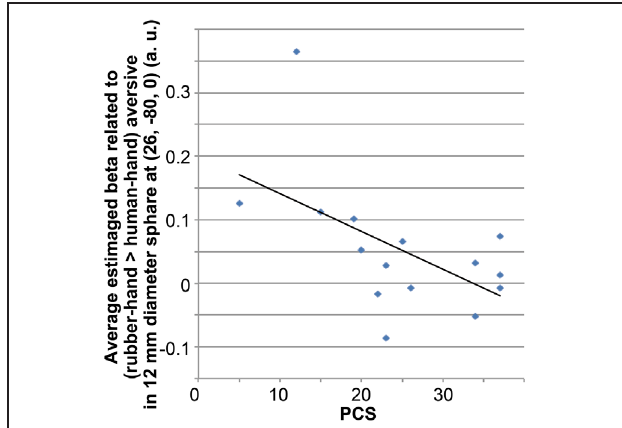
FIGURE 5 | Correlation between average beta value related to (rubber-hand > human-hand) aversive condition and total PCS score. Average beta value was calculated within a sphere of 12-mm diameter located at the peak of significant activation from the interaction between hand effects and aversive